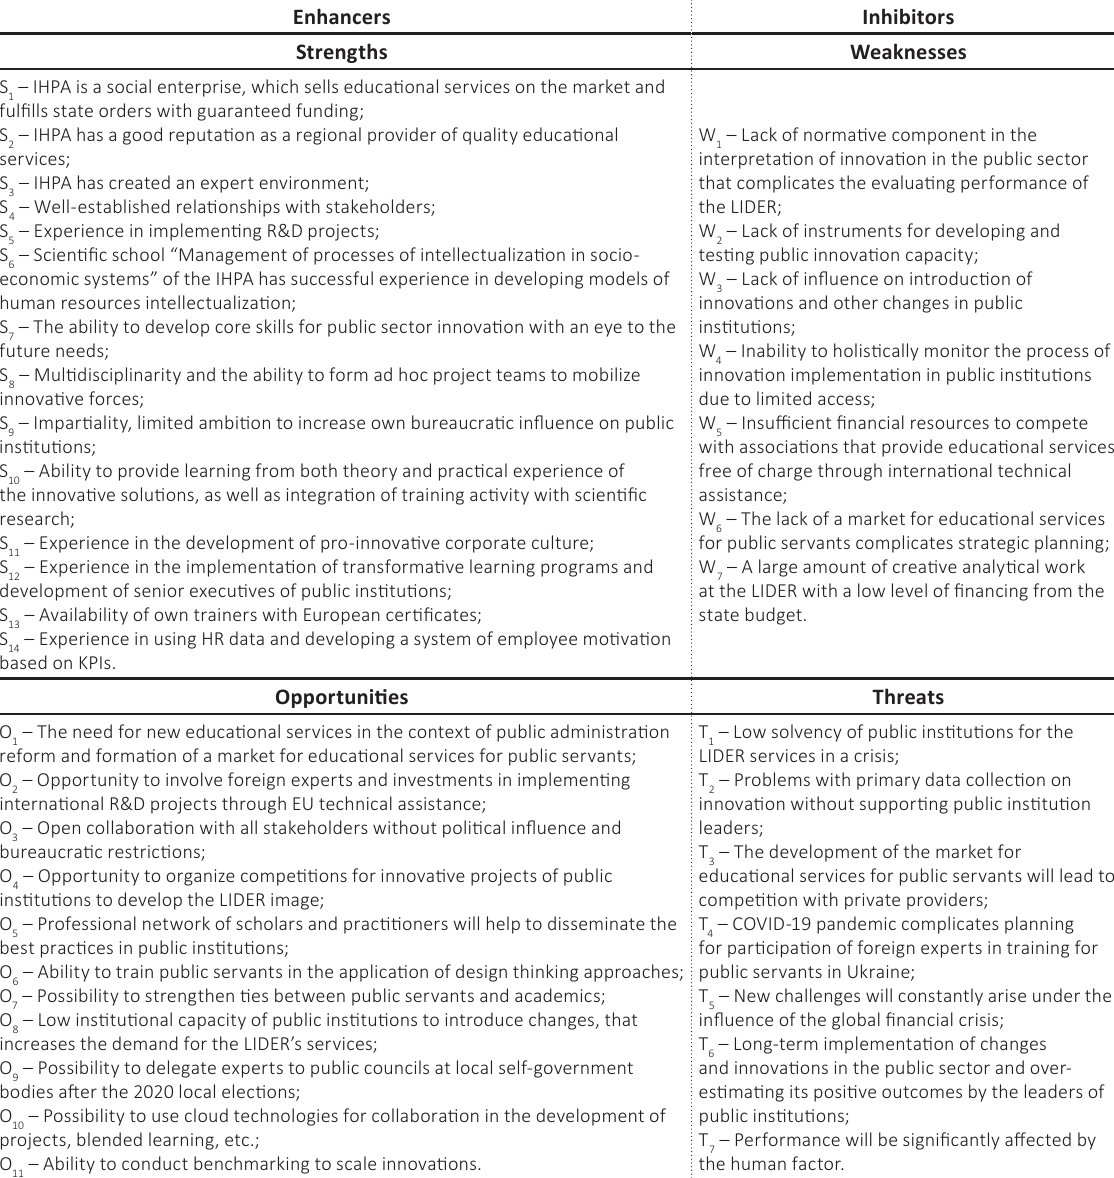
Table 1. SWOT-matrix for analysis of the development opportunities for the LIDER